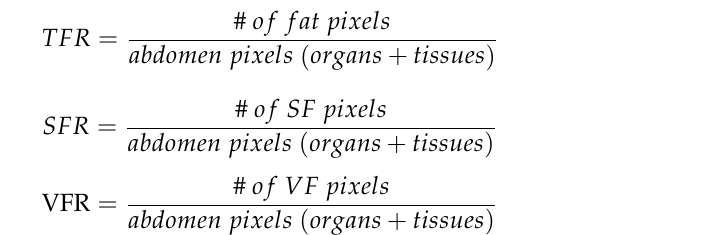
Figure 13. Variation of liver HU values. ( a ) Low HU value, ( b ) high HU value.